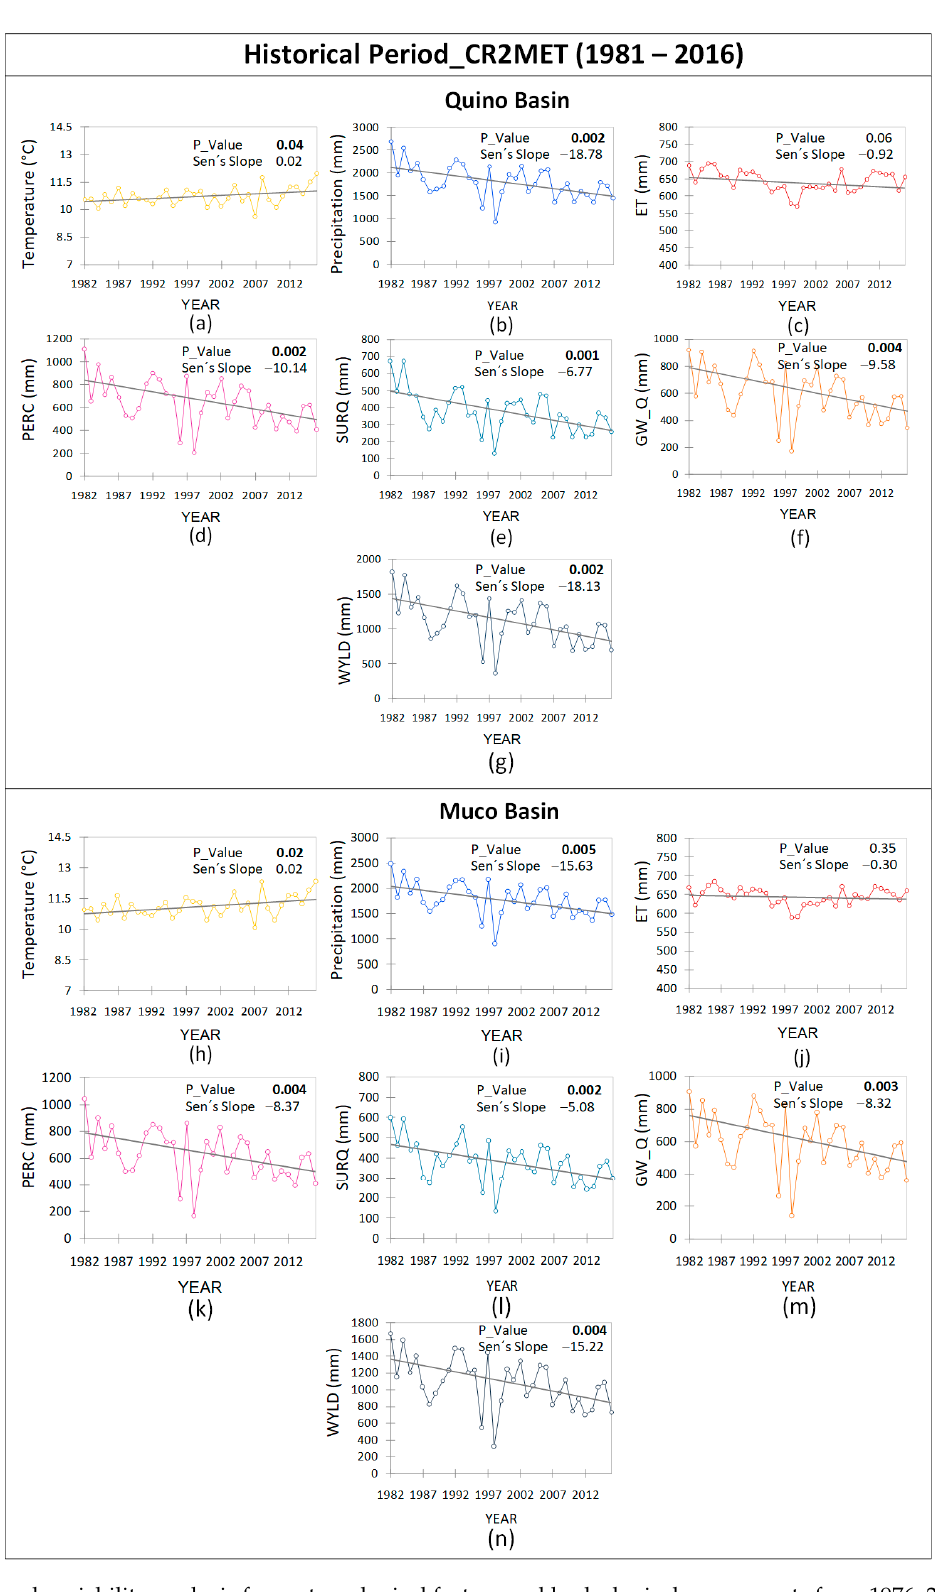
Figure 4. Annual variability analysis for meteorological factors and hydrological components from 1976–2016 in Quino (left) and Muco (right) basins. Mann–Kendall test (MK) (significance level 0.05) and Sen’s slope ( β > 0 increasing trend and β < 0 decreasing trend). Temperature, precipitation, evapotranspiration (ET), percolation (PERC), surface flow (SURQ), groundwater (GW_Q) and water yield (WYLD).